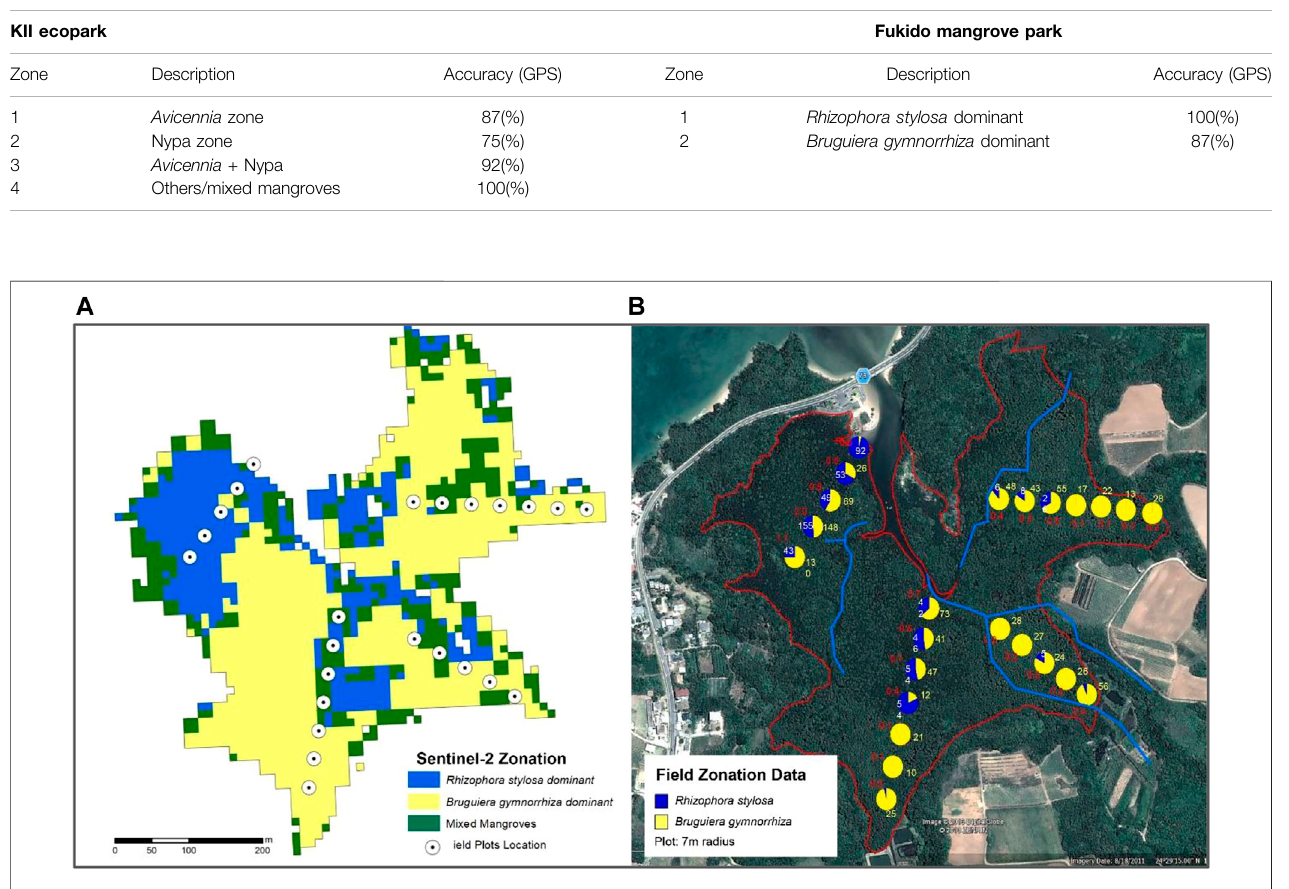
Frontiers in Remote Sensing |